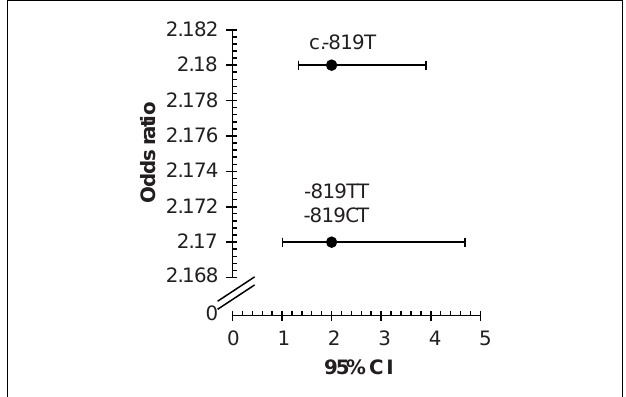
FIGURE 2 | Odds ratios for associations between IL10 c.-819C > T, and -819TT, -819CT (rs1800871) with Behçet’s disease .The two SNPs c.-819C > T and c.-592C > A are in total linkage disequilibrium in our sample; therefore, the results of only one SNP c.-819C > T is considered. CI, confidence interval; rs, reference SNP; SNP, single nucleotide polymorphism.